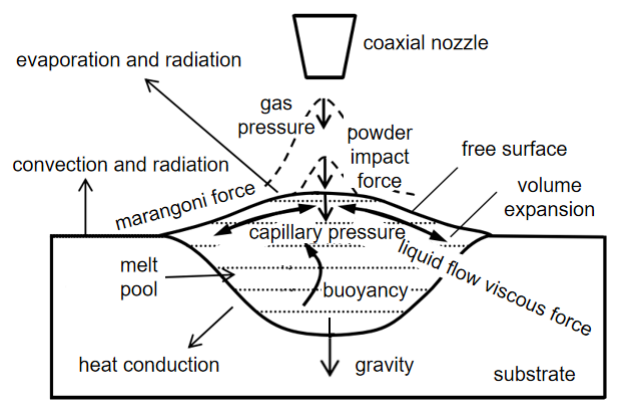
Figure 2. The stress state of the molten pool in the LMD process [51].